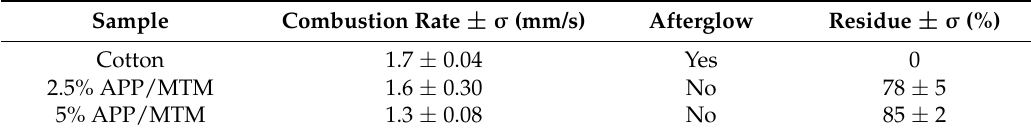
Figure 4. Snapshot of flame-spread tests of untreated and treated cotton fabrics. Table 3. Flammability data from horizontal flame tests of untreated and treated cotton fabrics.